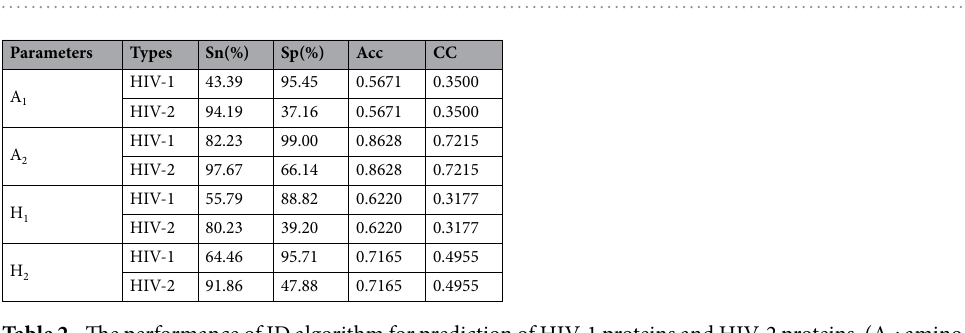
Table 2. The performance of ID algorithm for prediction of HIV-1 proteins and HIV-2 proteins. (A 1 : amino acid composition;